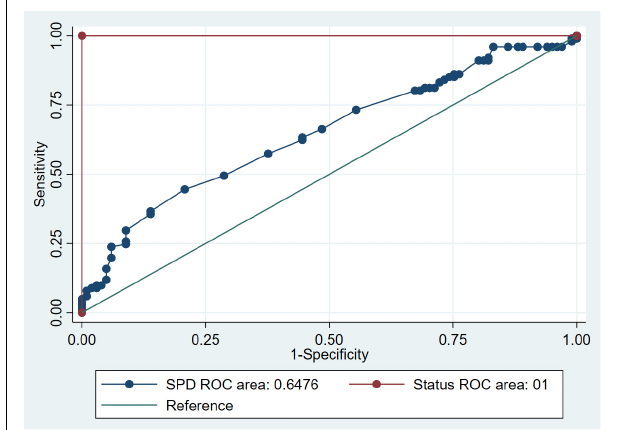
FIGURE 2 | Receiving operating characteristics curves for incident stroke from SPD of nested case-control